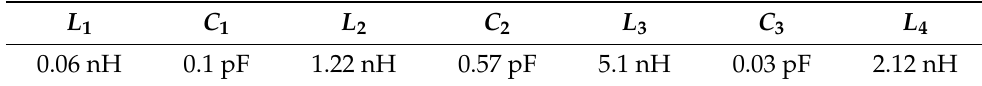
Figure 6. ( a ) The EC of the triple band-pass FSS. ( b ) Schematic diagram of the triple band-pass FSS. According to the design goals, the component values of the triple band-pass filter circuit can be received, as shown in Table 4. Table 4. The EC parameters value of triple band-pass FSS.